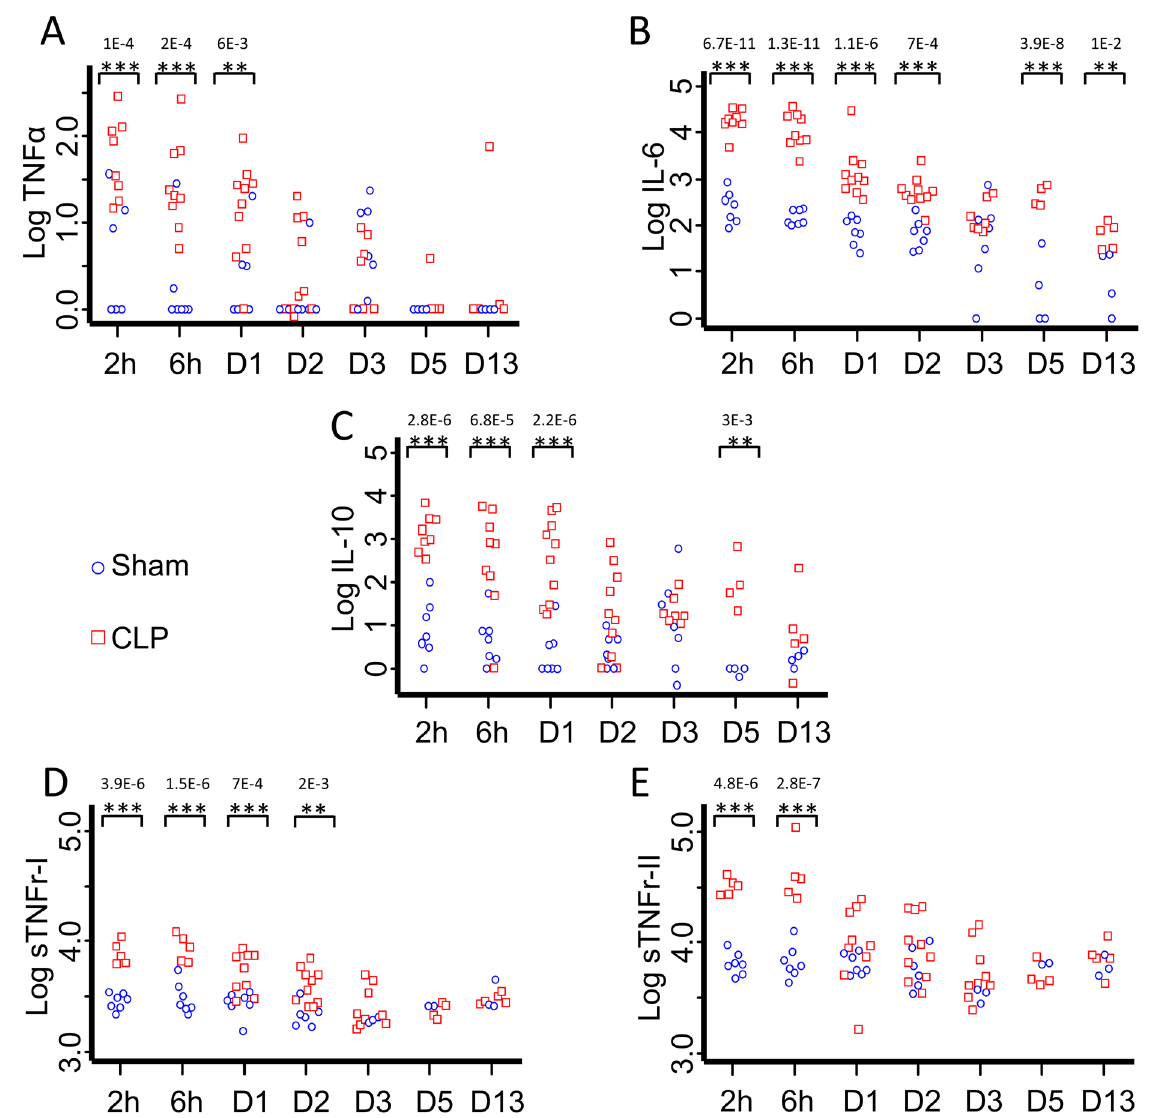
Fig 3. Plasmatic cytokines assessment after CLP. Plasma was collected 2 and 6 hours, 1 (D1), 2 (D2), 3 (D3), 5 (D5) and 13 (D13) days after CLP or Sham surgery with no secondary infection to measure TNF α , IL-6, sTNFr I and II and IL-10 concentrations thanks to the Luminex technique. At D0, before surgery, TNF α , IL-6 and IL-10 were undetectable. Both sTNFr were detectable in healthy mice. Pro-inflammatory cytokines TNF α (A) and IL-6 (B) are significantly increased as soon as 2h after sepsis induction, as anti-inflammatory mediators IL-10 (C) and sTNFr-I and II (D and E). TNF α was not detected anymore in Sham operated mice at D5 and D13. Results are expressed as Log(pg/ml). p values given are corrected p values according to the Bonferroni correction. * CLP vs Sham p < 0.05, ** CLP vs Sham p < 0.01, *** CLP vs Sham p < 0.001.